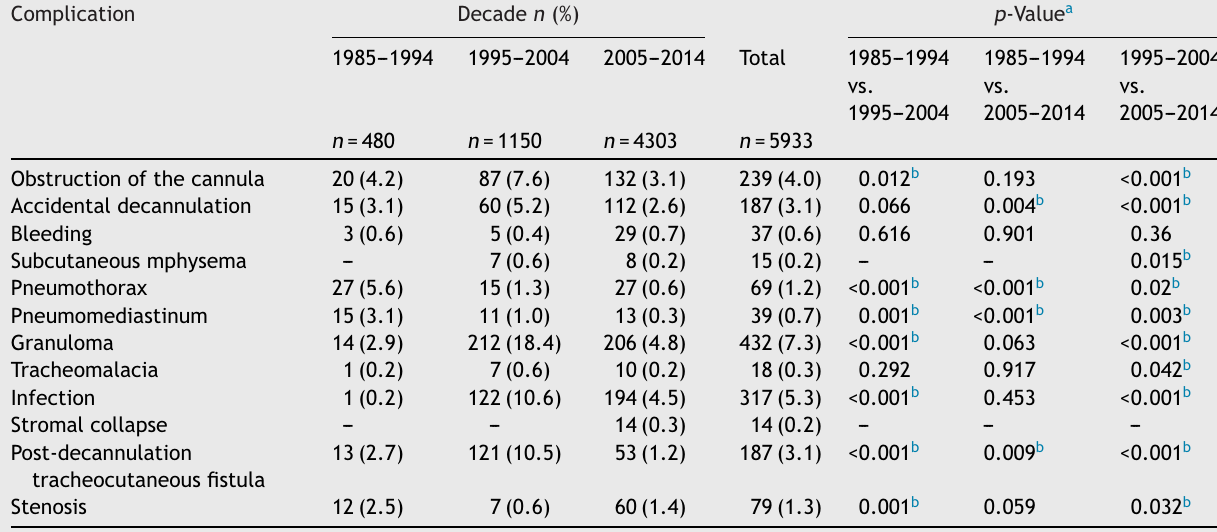
Complications in children who received a tracheostomy between 1985 and 1994, between 1995 and 2004, and between 2005 and